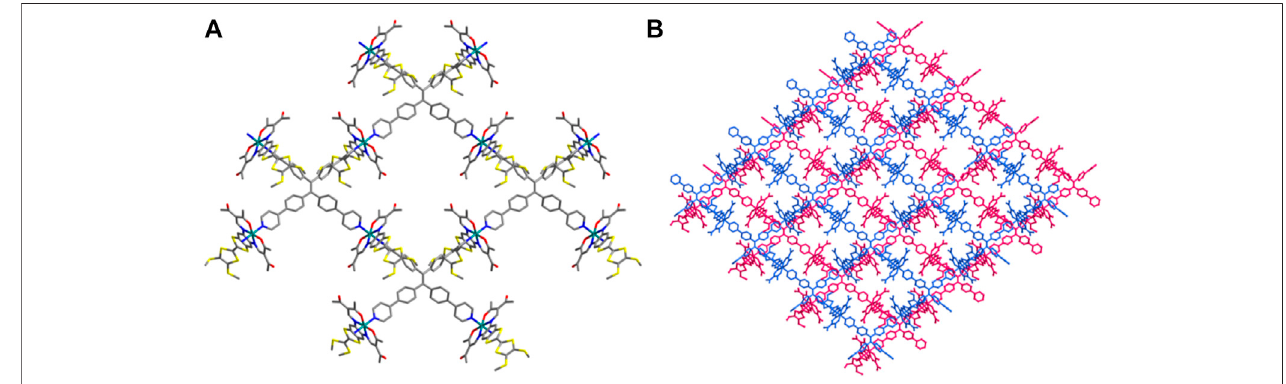
FIGURE 1 | 2D network (A) and adjacent interdigitated layers (two layers are shown with two different colours) along the a axis (B) for 1 . All of the hydrogen atoms are omitted for clarity, carbon - grey, nitrogen -blue, oxygen - red, sulfur - yellow, iron - teal.